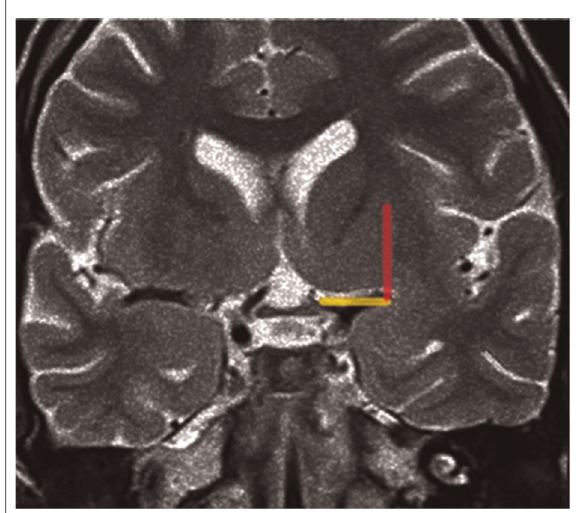
FIGURE 9 Coronal T2-weighted MRI at the level of the optic chiasm as an imaging parameter of the anterior perforated substance. The imaginary line (the Optic Chiasm – Insular Recess line) is drawn, from the optic chiasm medially to the insular recess laterally, to identify the anterior perforated substance (yellow line). The Porto Alegre line (Red Line) is as ascendent line from the lateral end of the OC-IR line and represents the lateral limit of the lateral LSTa inside the central core. In cases which the medial border of insular tumor crosses this line medially there is a great probability of involvement of the LSTa by the